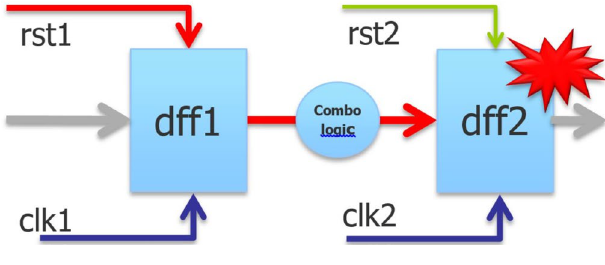
Figure 3. Reset domain crossing